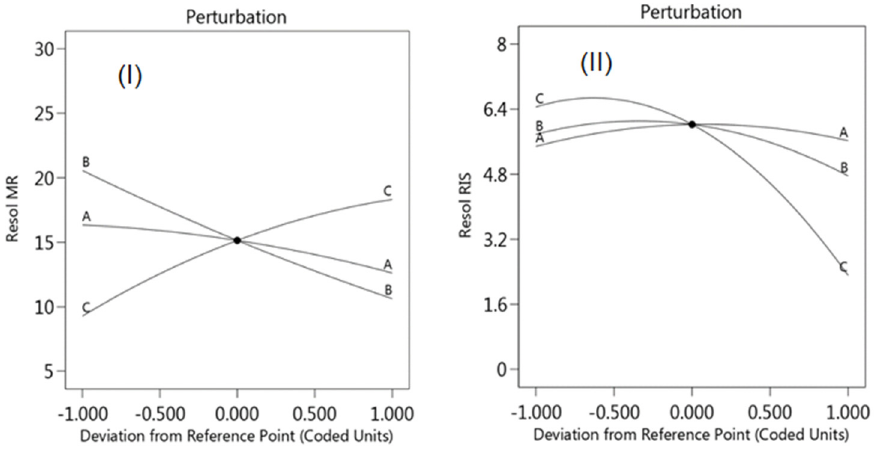
Figure 5. Perturbation plots showing the effect of percent of SDS (A), percent of acetonitrile (B) and pH of the mobile phase (C) on the resolution of MFH to RGE ( I ) and RGE to IS ( II ).